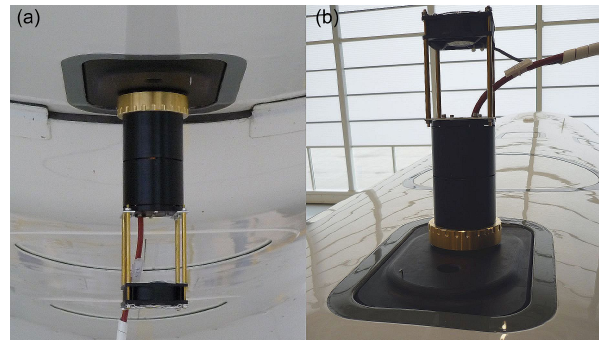
Figure 9. In-field-calibration setup with traveling standard lamps attached to receiver optics on HALO. (a) bottom fuselage; (b) top